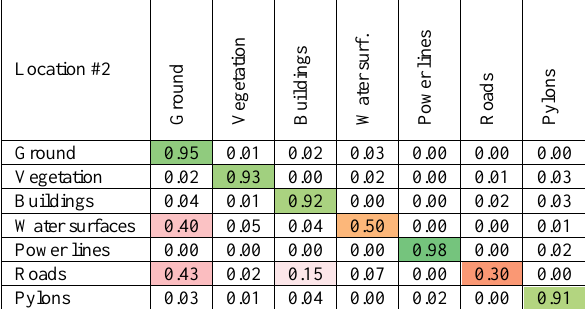
Table 6. Confusion matrix after multi-source semantic segmentation of Location #2.